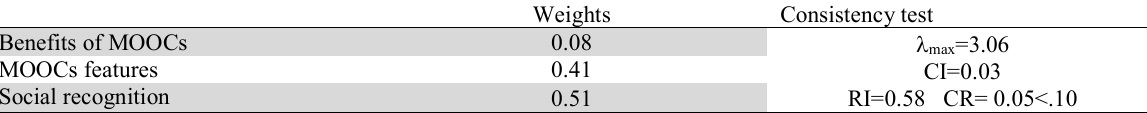
Analysis of the main factors